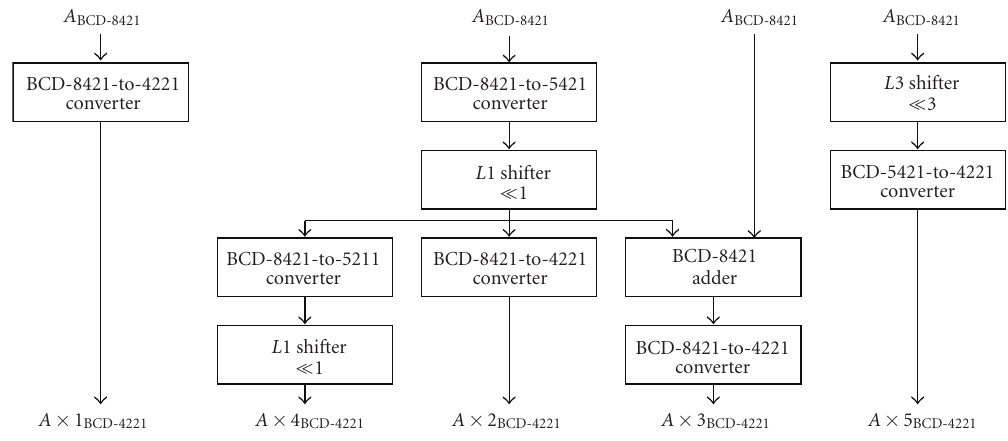
Figure 4: Multiplicand multiples